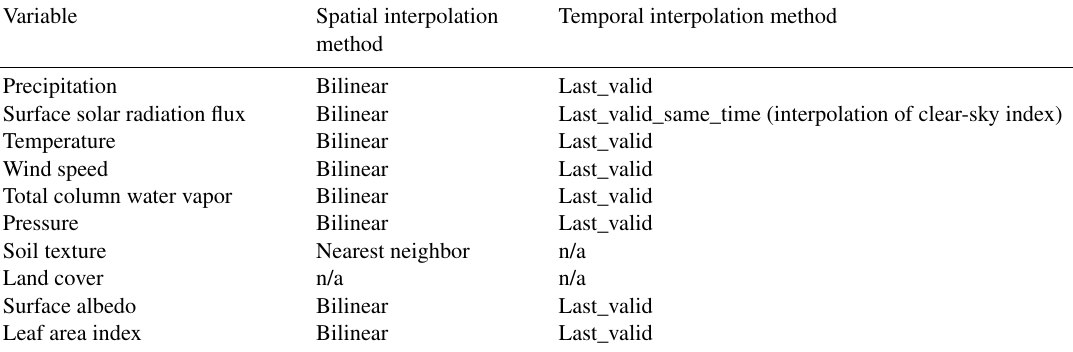
Table B2. Summary of spatial and temporal interpolation methods used within the HOLAPS framework for different driver variables.